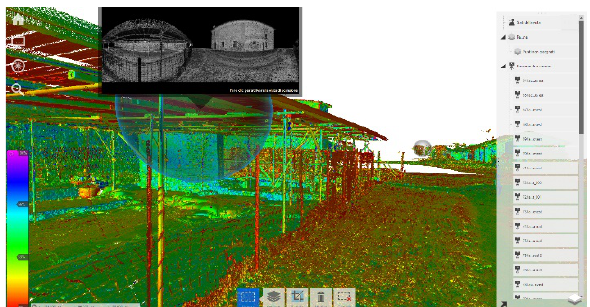
Figure 4: point-cloud of the archaeological area- The point- clouds are colored according to intensity. On the right, the structure of the 3D database with different scans. In the box, it's possible to see the scan as a panorama view.